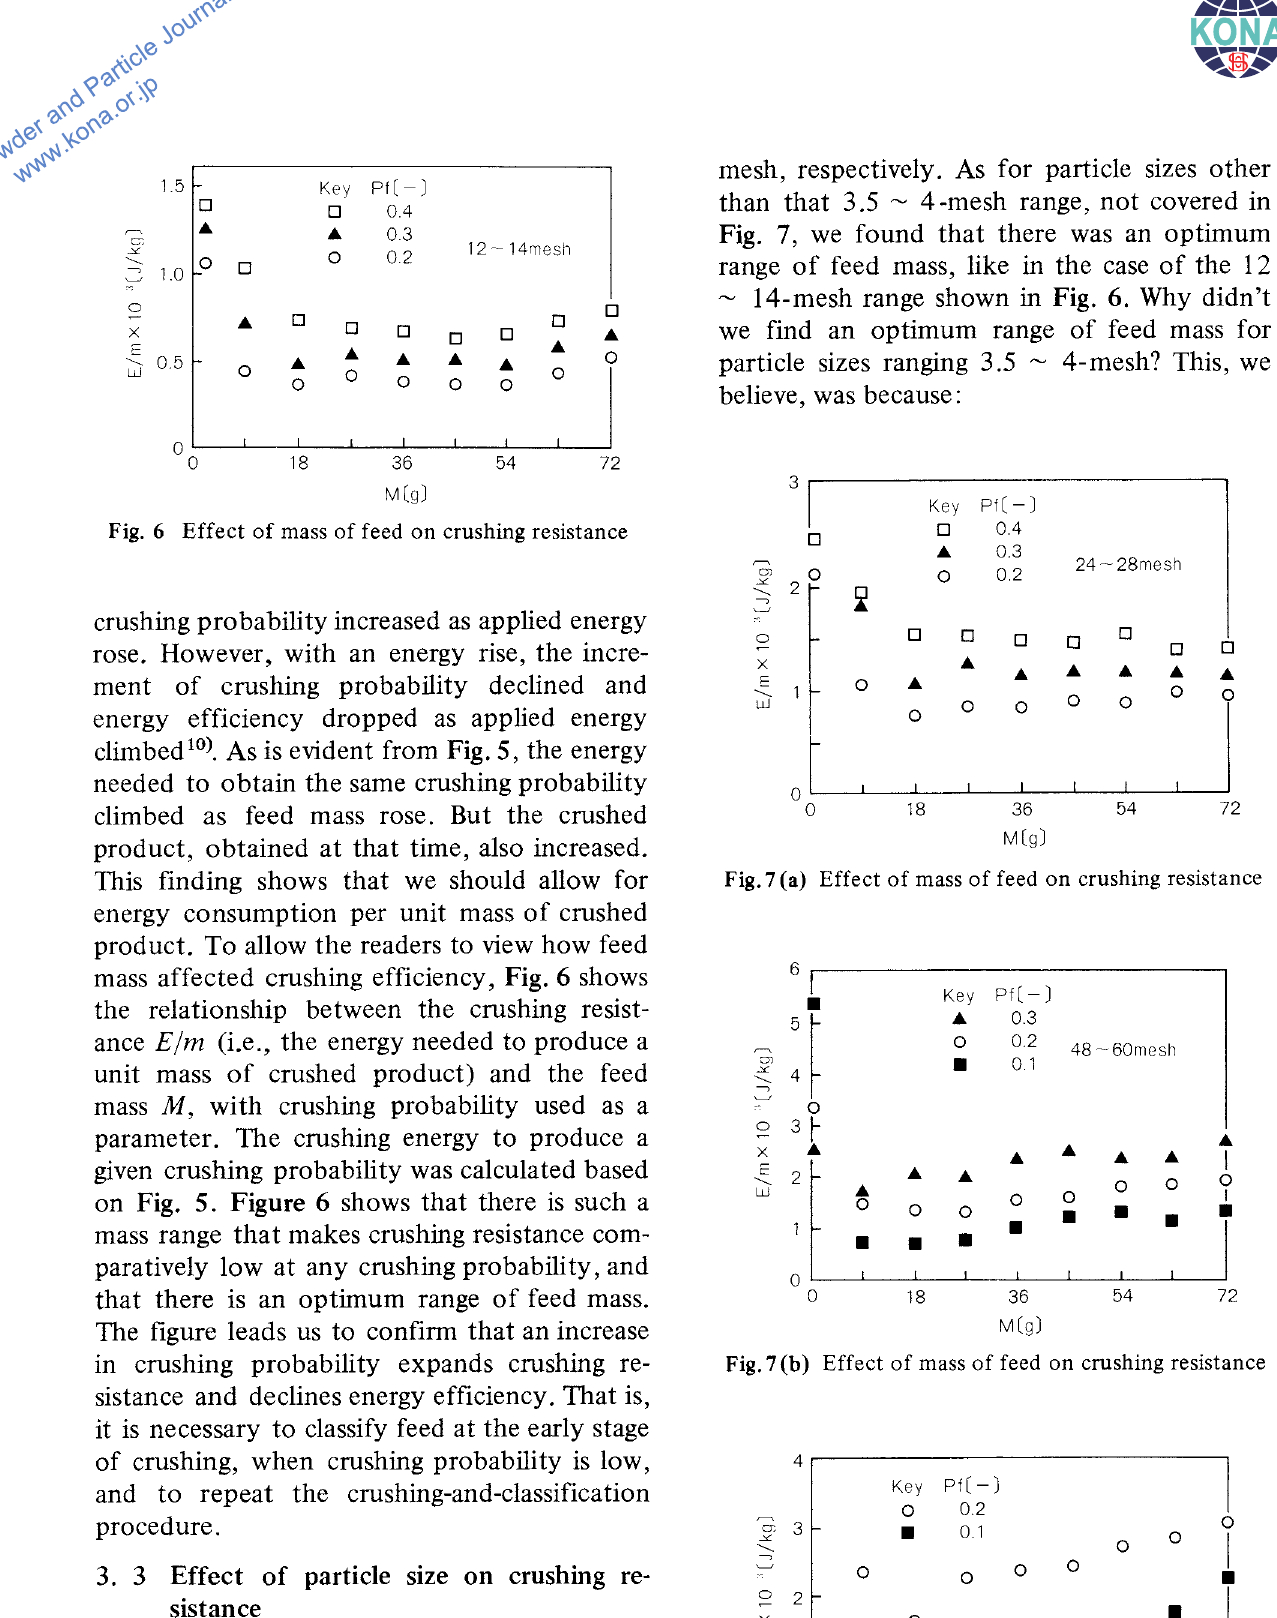
Fig. 7(b) Effect of mass of feed on crushing resistance